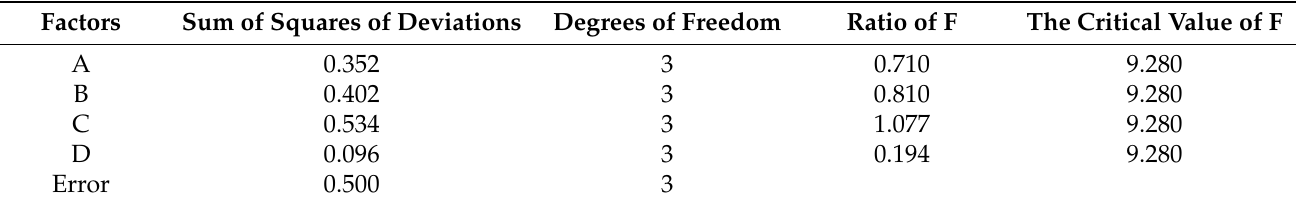
Table 3. Results of variance analysis of orthogonal